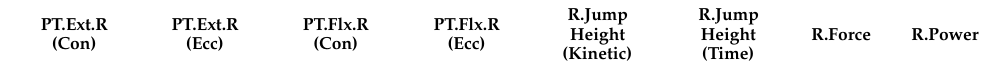
Table 3. Person’s correlation matrix between all isokinetic and force platform variables measured from the countermovement jump of the dominant